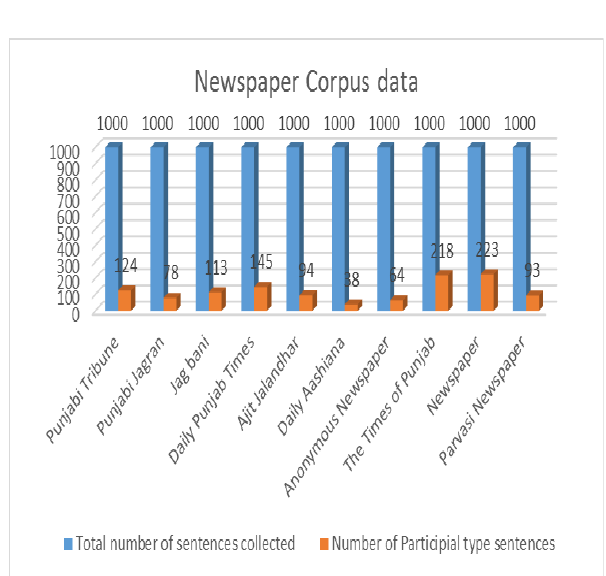
Figure 4. Details of e-paper corpus used for testing